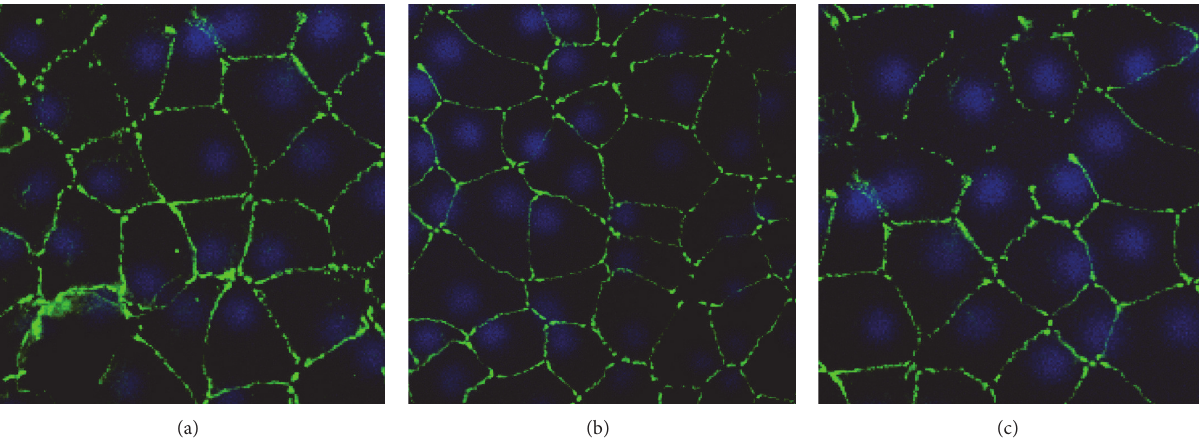
Figure 3: Immunostaining results using ZO-1 marker for expression of tight junctional proteins in the preloaded DMEK lenticules visualized at 400x magnification. Preserved cells showed expression of these proteins confirming the integrity of the endothelial cells. However, ((a) and (c)) C1 and C3, respectively, showed some areas without endothelial cell borders and hence loss of tight junctions whereas (b) C2 expressed tight junction protein with less polymorphism compared to C1 and C3. Hexagonality of the cells was observed in